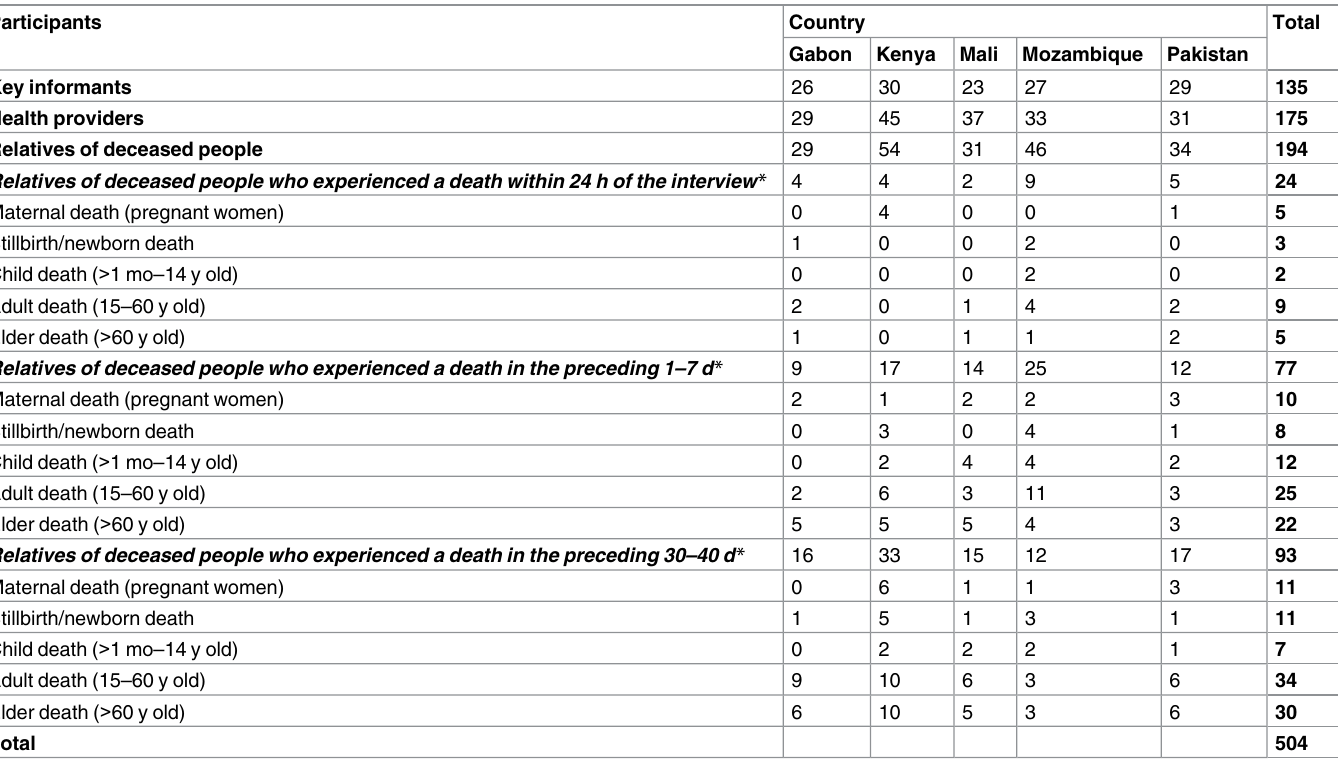
Table 1. Number of interviews by target group and